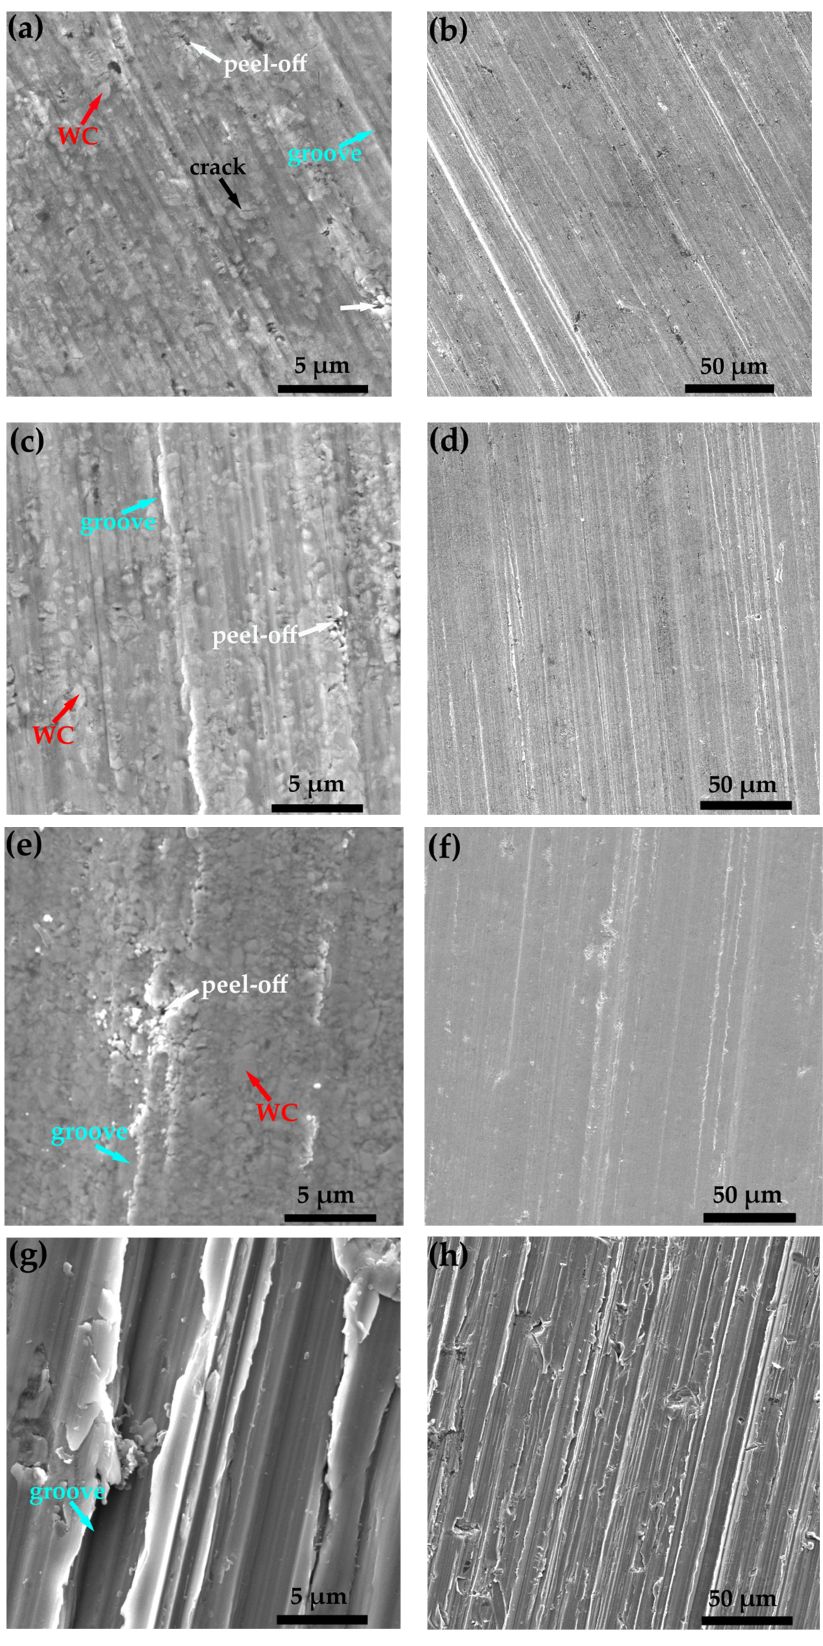
Figure 18. Worn surface morphologies of WC-17 coatings formed by various spraying methods and Q235 steel substrate ( a , b ) HVOF, ( c , d ) WS, ( e , f ) CS, ( g , h ) Q235 steel substrate.